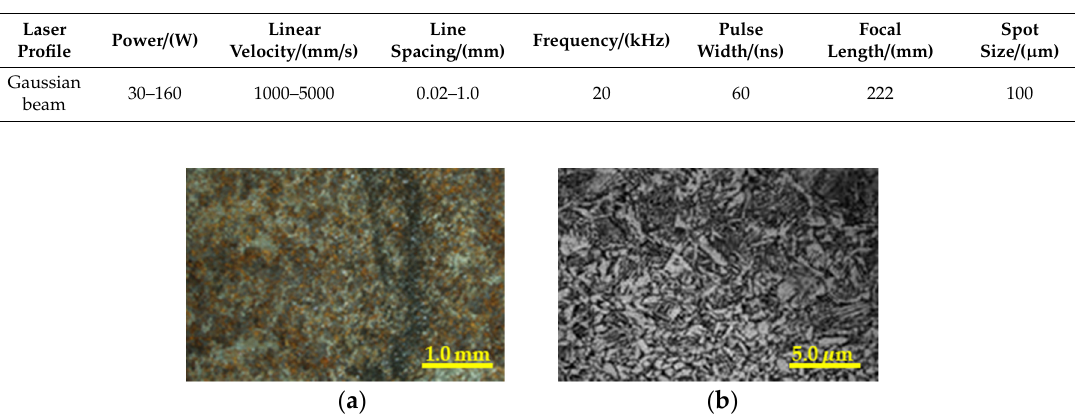
Table 3. Color difference of workpieces after cleaning.